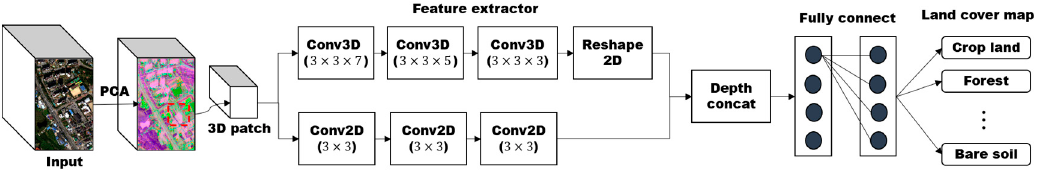
Figure 2. Process of step1 in discrepancy analysis: hyperspectral UAV image classification for generating the land cover map. PCA: principle component analysis.